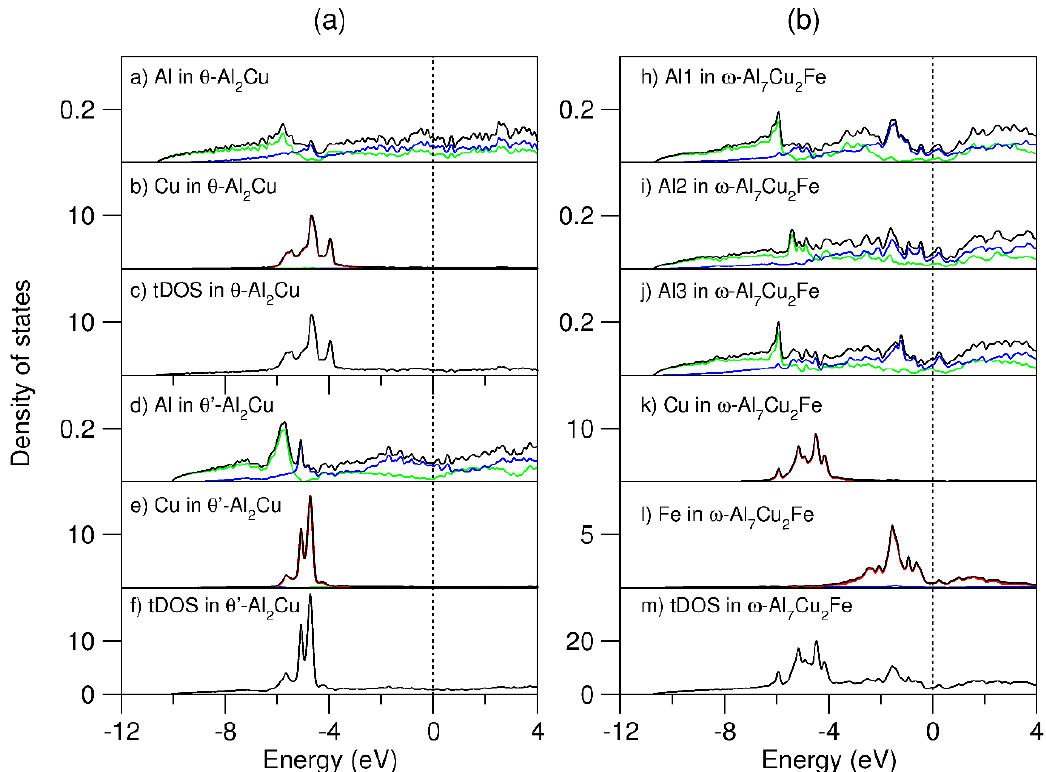
Figure 3. (Color on line) Partial and total density of states for the Al-rich Cu-containing compounds in Al-Fe-Cu system using the DFT-GGA with Hubbard U correction for Cu 3d electrons. Subfugures a) to c) for the partial density of states (pDOS) of atoms in and total density of states (tDOS) of θ -Al 2 Cu, d)-f) θ ’-Al 2 Cu in ( a ) and h)-m) for ω -Al 7 Cu 2 Fe in ( b ). For partial density of states, the green curves represent s-characters, the blue curves represent p-characters, and the red curves represent d-characters. The black curves represent the total DOS. The unit for pDOS is states/eV per atom and for tDOS is states/eV per formular unit.